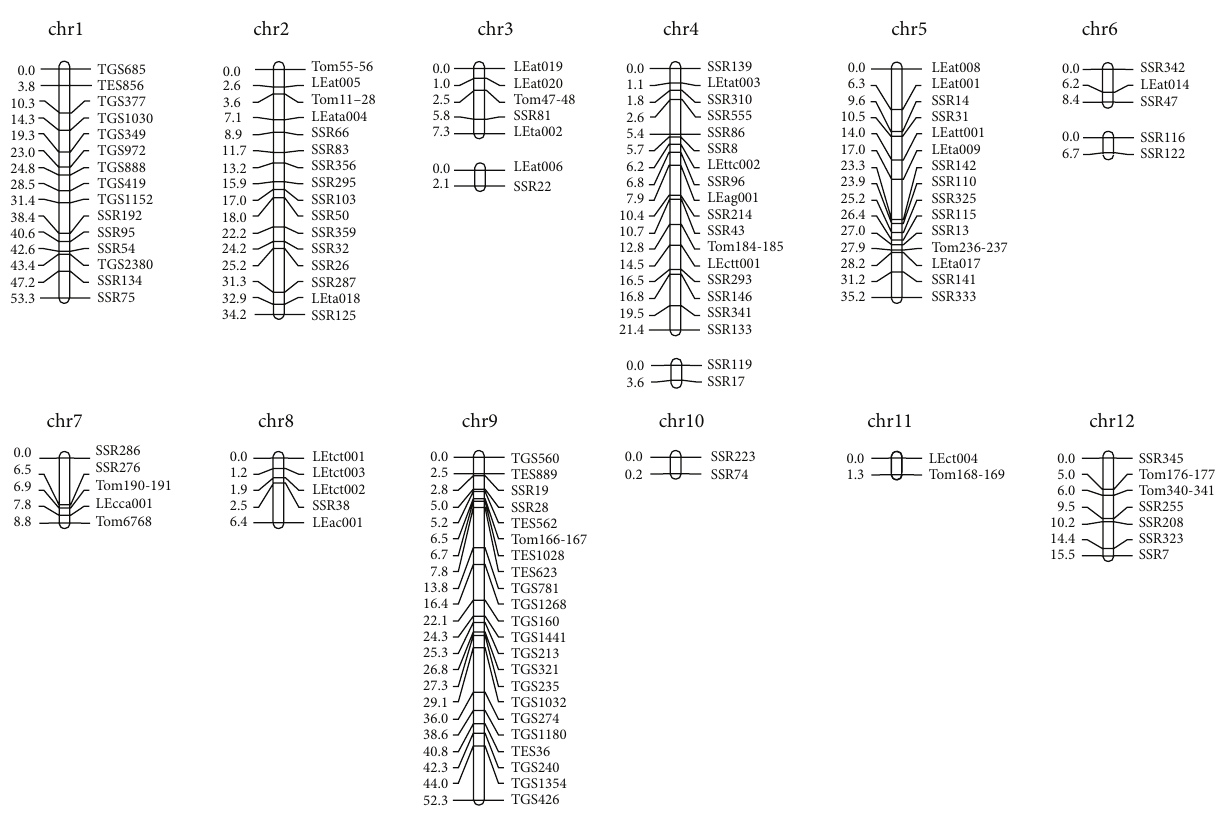
Figure 2: The genetic linkage map for SSR makers in RIL population.